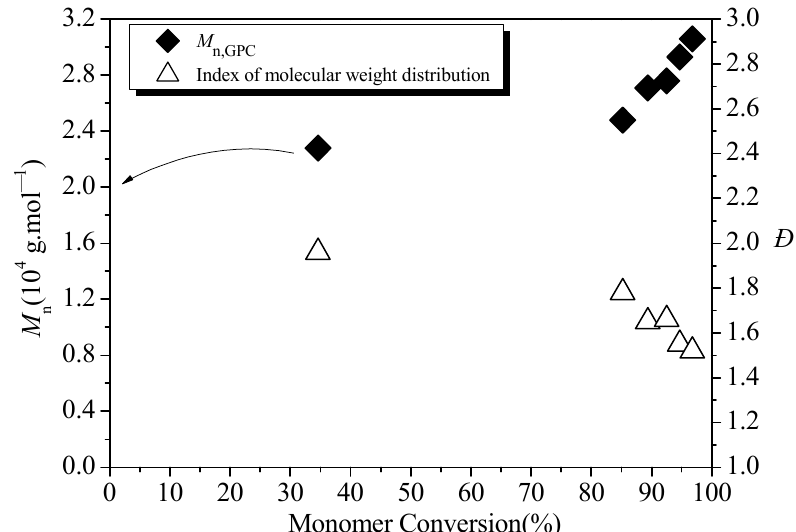
Figure 6. Evolution of measured M n and Ð with monomer conversion for RITP emulsion copoly- Figure 6. Evolutionofmeasured M n and Ð withmonomerconversionforRITPemulsion merization.